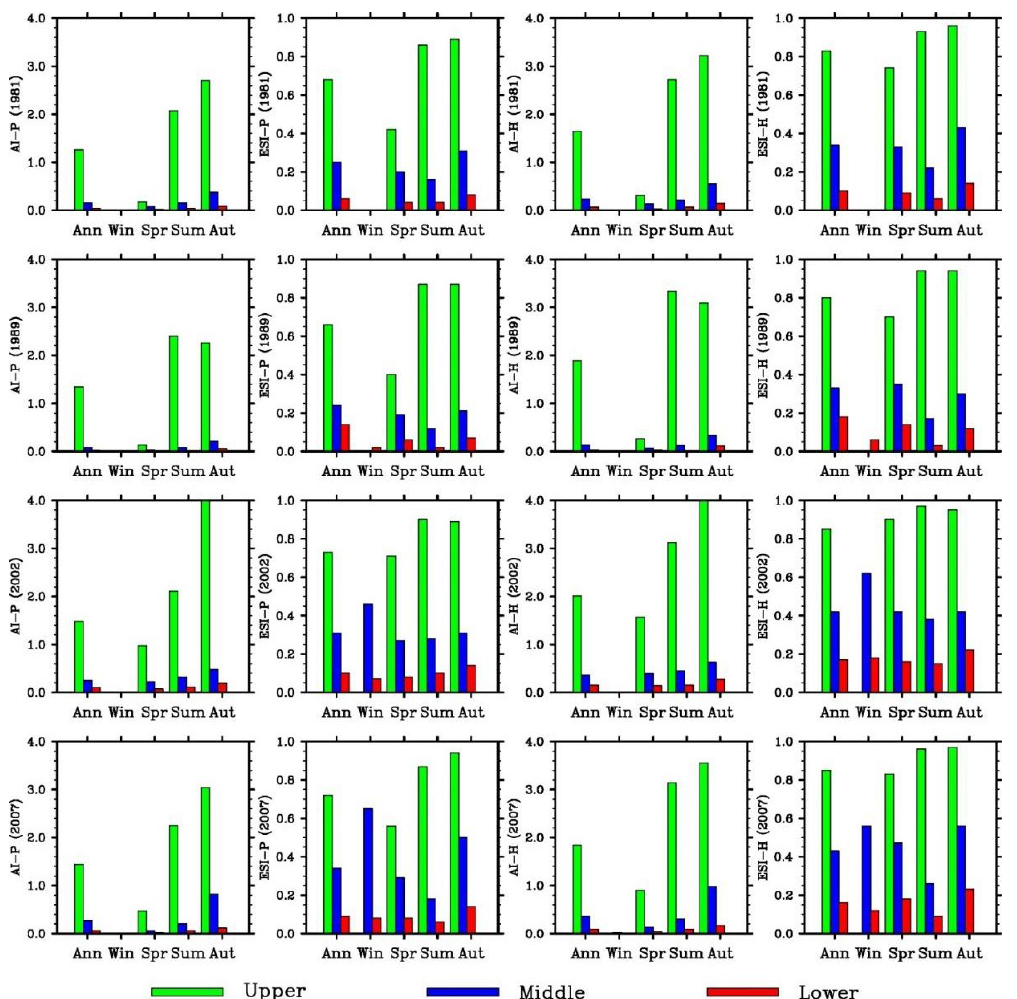
Figure 11. Seasonal variations of the simulated aridity index and evaporative stress index using the Penman–Monteith and Hamon methods (left to right) for the wet years of 1981, 1989, 2002, and 2007 (from top to